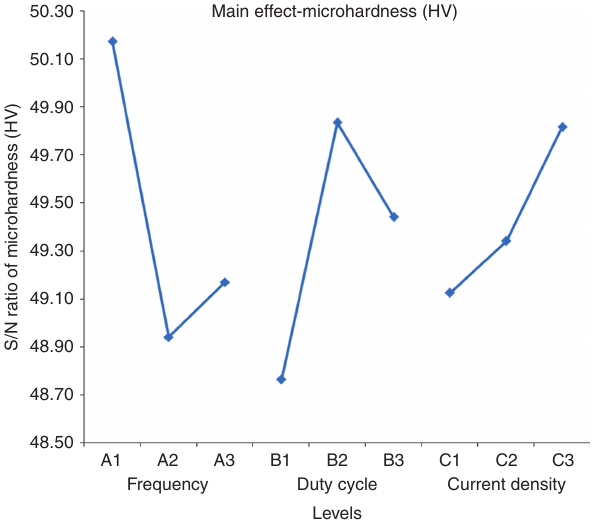
O composite 2 3